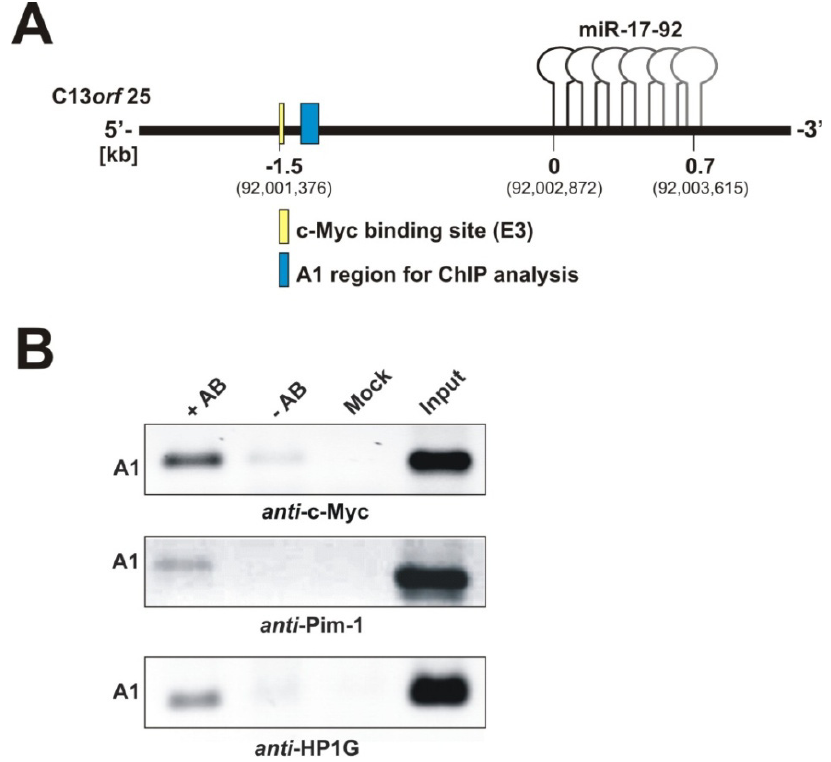
Figure 2. ( A ) Schematic representation of the intronic A/T-rich region preceding the miR-17-92 coding sequence. The region A1 (blue box) defines the genomic sequence 0.1 kb downstream of the functional c-Myc binding site (E3; yellow box) that was amplified in ChIP analyses; ( B ) ChIP analysis of the intronic region A1 in K562 cells, using antibodies specific for c-Myc, Pim-1 and HP1 γ . +AB: with antibody; − AB: without antibody; Mock: buffer only without cell lysate; Input: supernatant of the − AB-sample after immunoprecipitation and centrifugation (for details, see Supplementary